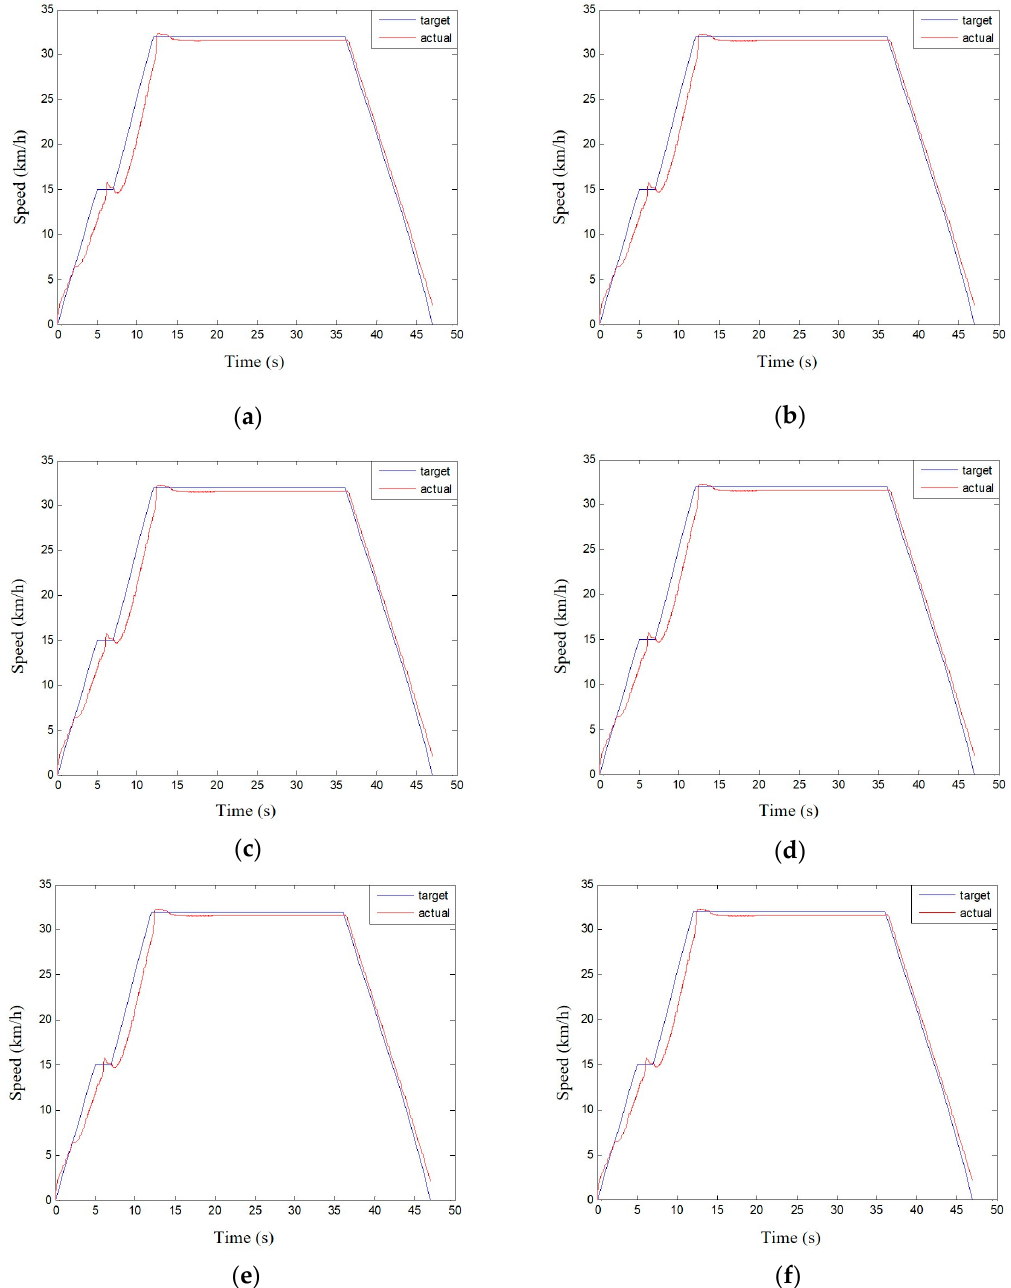
Table 5. The standard deviation of the vehicle speed corresponding to the compensable coefficient for different motors under working condition A.